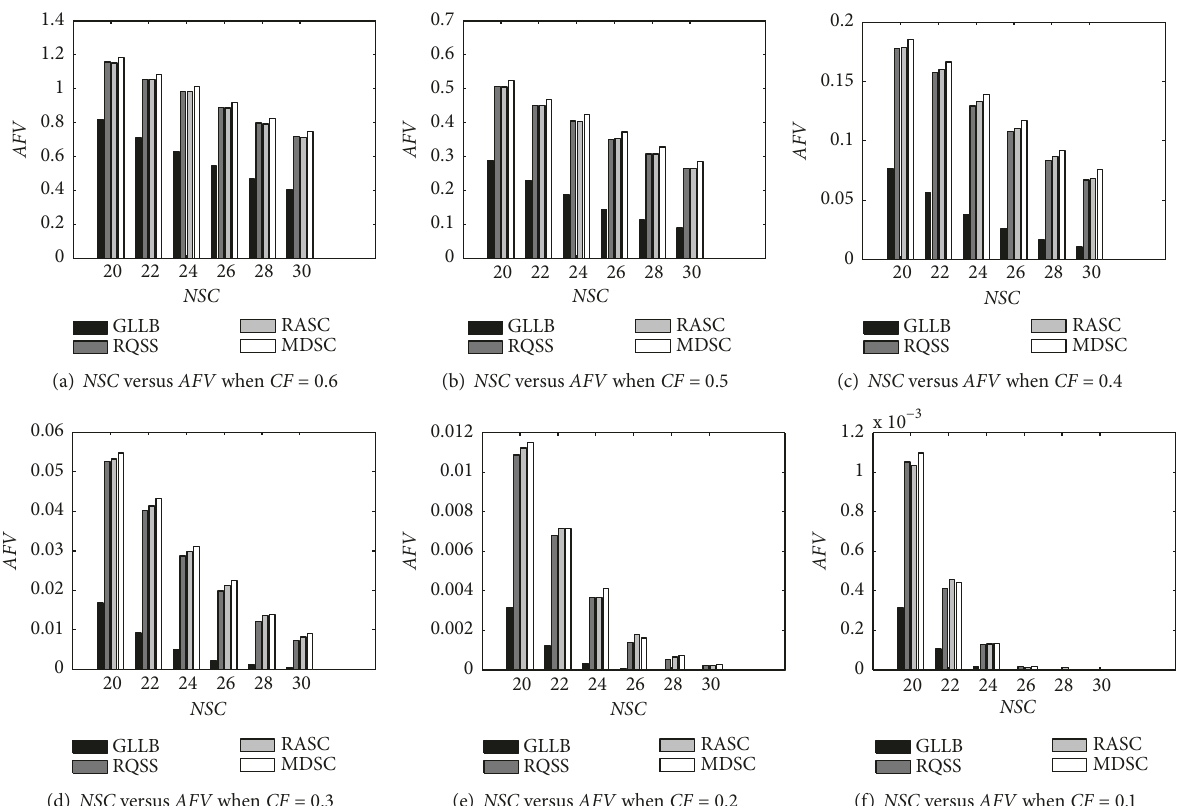
Figure 6: The Average failure value to the soft QoSs of different